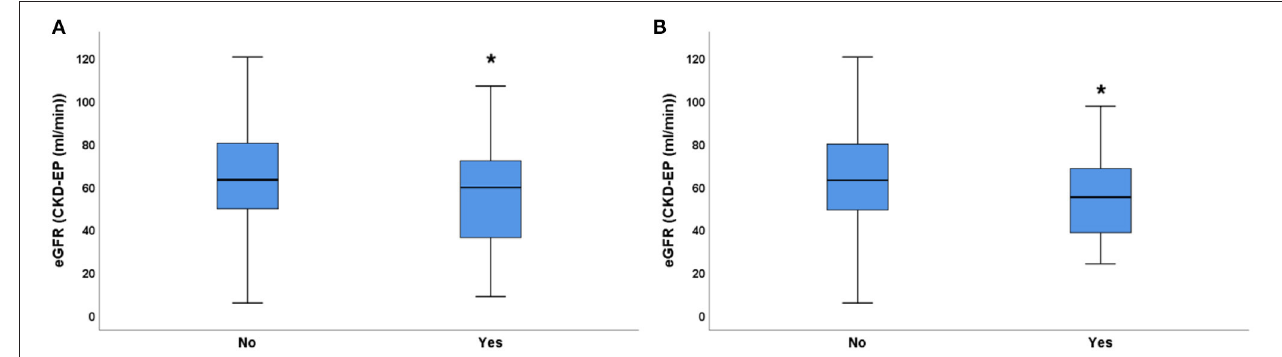
FIGURE 5 | EGFR values in patients with or without peripheral vascular disease and myocardial infarction. (A) peripheral vascular disease (verified atherosclerosis) (B) myocardial infarction. Unpaired t -test with Welch’s correction. * p < 0.05.